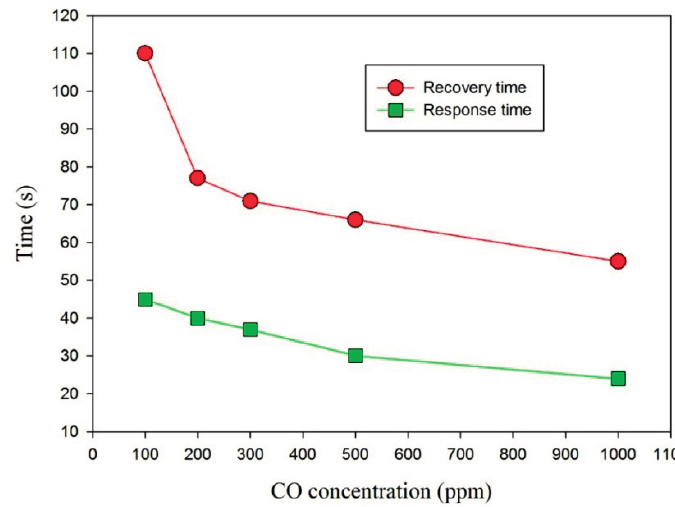
Figure 10. Relationship between CO concentrations, and the response and the recovery time for the gas sensors at a higher operating temperature of 180